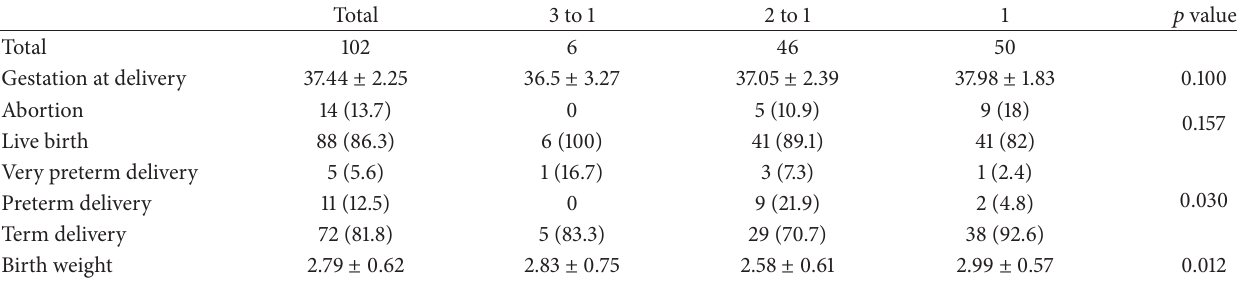
Table 2: Outcome in singleton pregnancies (reduced and